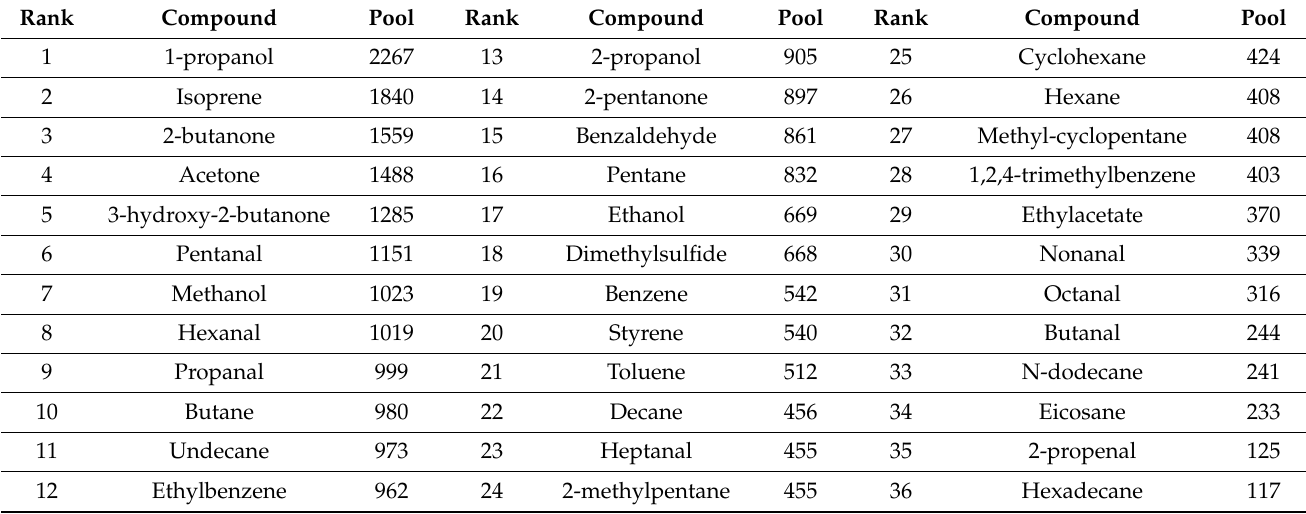
Table 1. Ranking of compounds by sample pool size (each compound has been cited three times as potential biomarker or